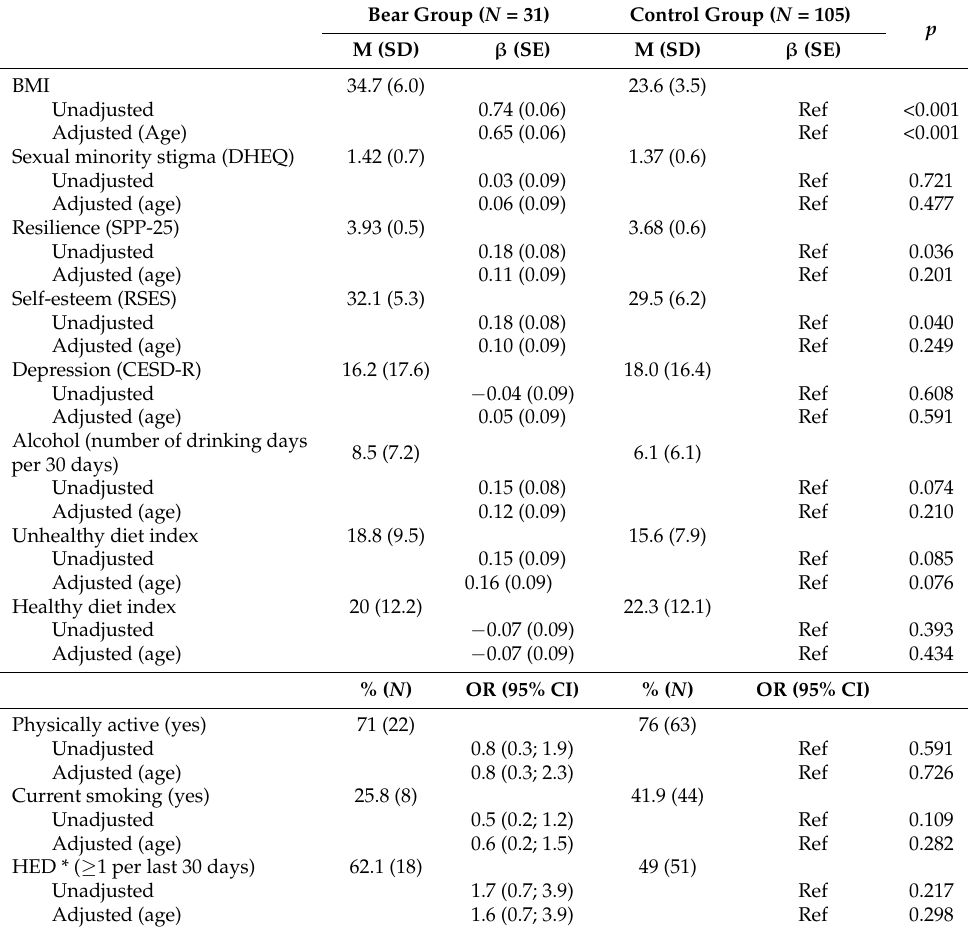
Table 2. Comparison of Bears with other gay men in terms of selected behavioral and psychosocial risk factors for cardiovascular